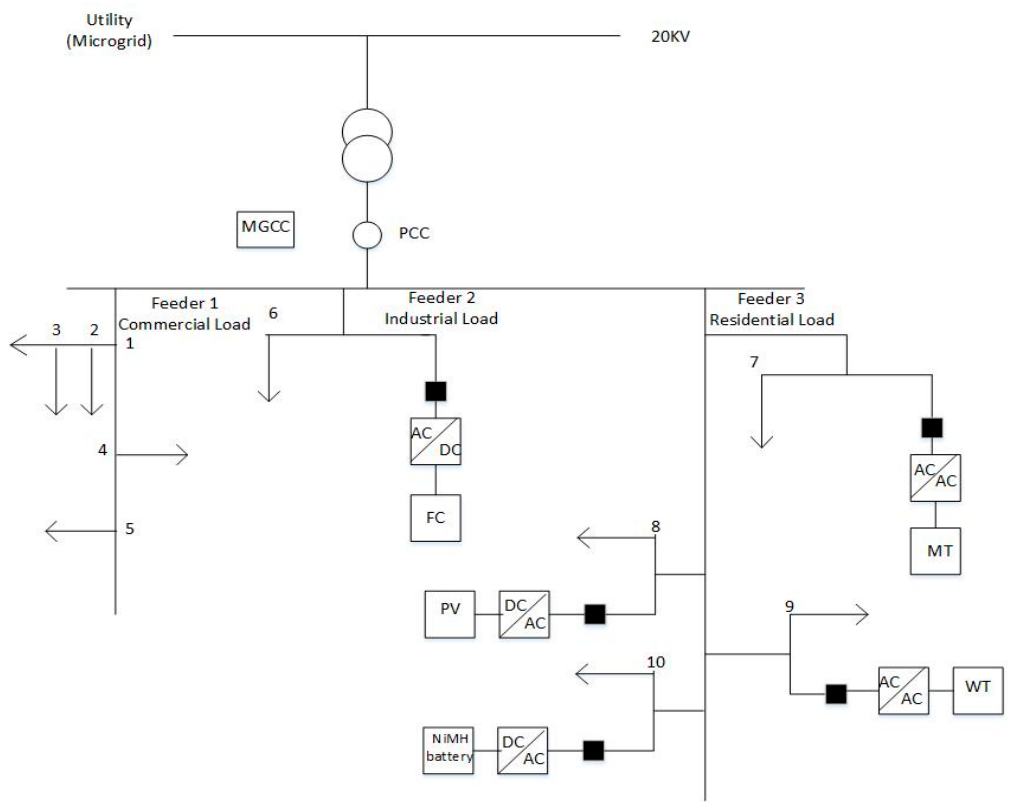
Figure 2. Typical low-voltage MG.